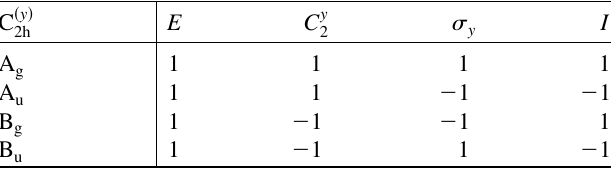
TABLE VI. Character table for the point group C (cid:4) y (cid:5) superscript (cid:4) y (cid:5) denotes that a twofold axis is the y axis.